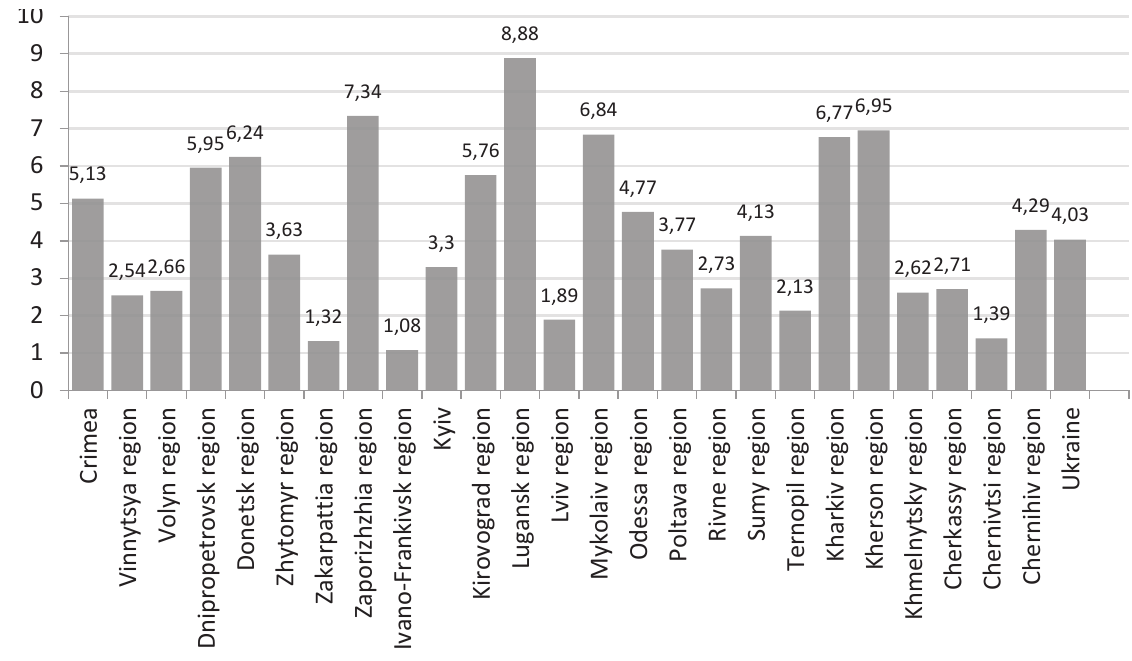
Figure 2. The average size of a land plot (share) in the regions of Ukraine,